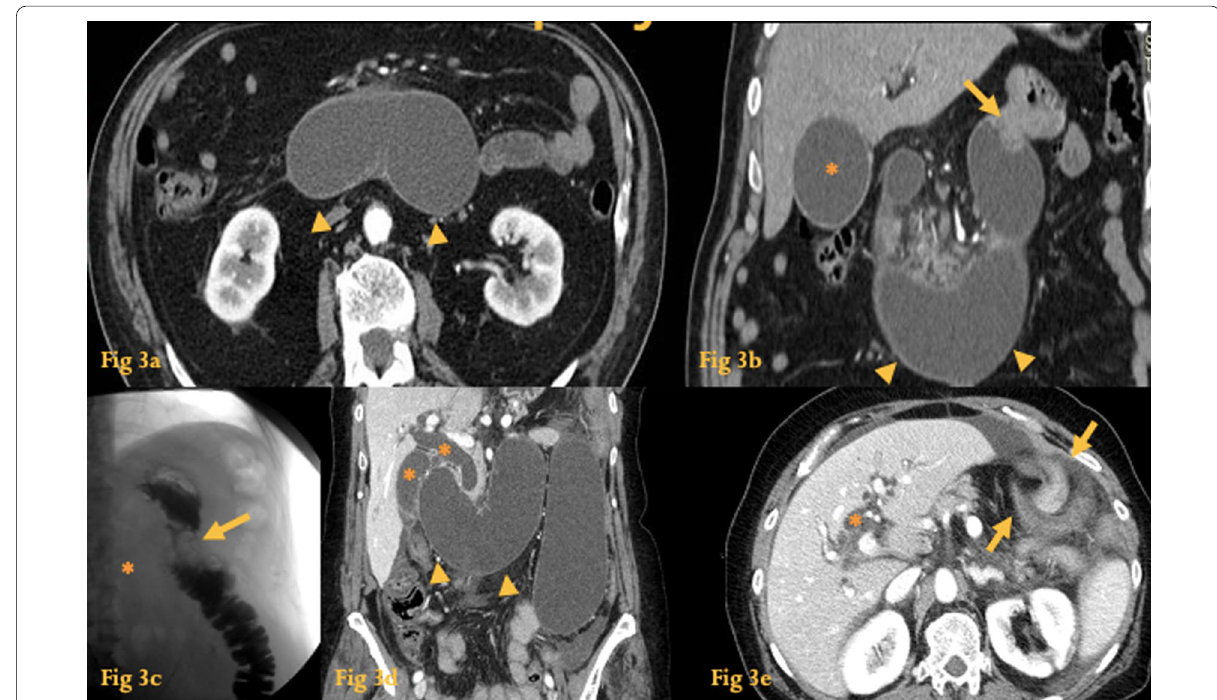
Fig. 3 Afferent Loop Syndrome. Abdominal CT ( a , b ) of a patient who had received partial gastrectomy with Billroth II reconstruction—A fluid‑filled tubular structure in the right upper quadrant and crossing the midline is seen, with associated gallbladder distension (asterisk). There is an enhancing lesion at the anastomosis. This was an afferent loop syndrome caused by gastric tumor recurrence. UGI series of the same patient ( c ). There is non‑filling of the afferent loop (asterisk) and a filling defect at the location of the anastomosis (arrow). Abdominal CT ( d , e ) of another patient with afferent loop syndrome, because of an internal hernia with volvulus (note the twisted configuration of the bowel loops at the left hypochondrium (arrows)). There is fluid‑filled dilatation of the afferent loop associated with gallbladder distension and intrahepatic